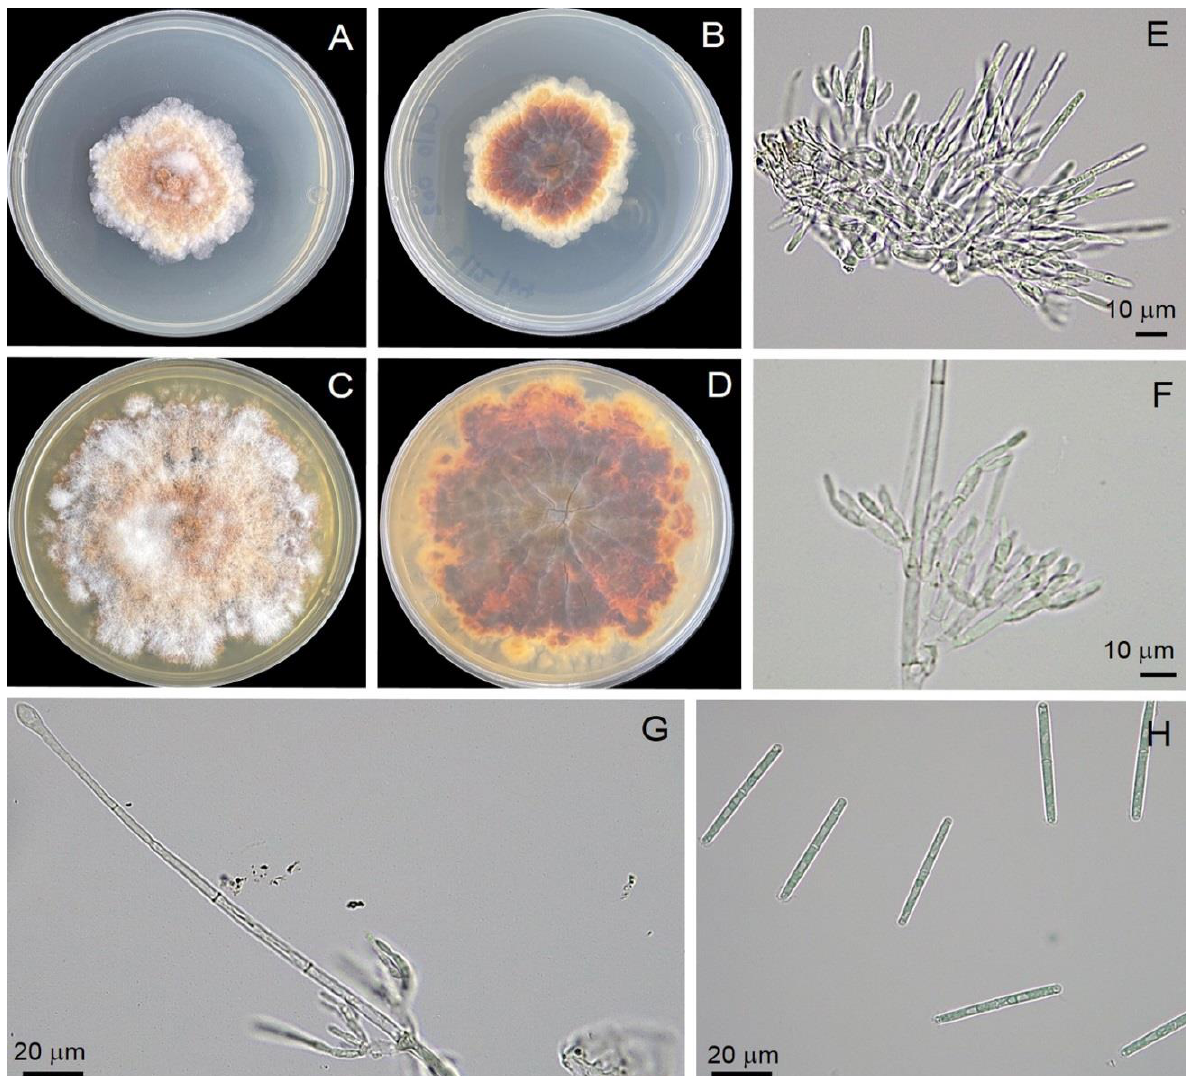
Figure 4. Morphological characteristics of the Calonectria foliicola Calkb001. Top view ( A ) and bottom view ( B ) of a colony on PDA at 7 days, top view ( C ) and bottom view ( D ) of a colony on PDA at 14 days, conidiogenous apparatus with conidiophore branches and doliiform to reniform phialides ( E , F ), obpyriform to ellipsoidal vesicle ( G ), macroconidia ( H ).